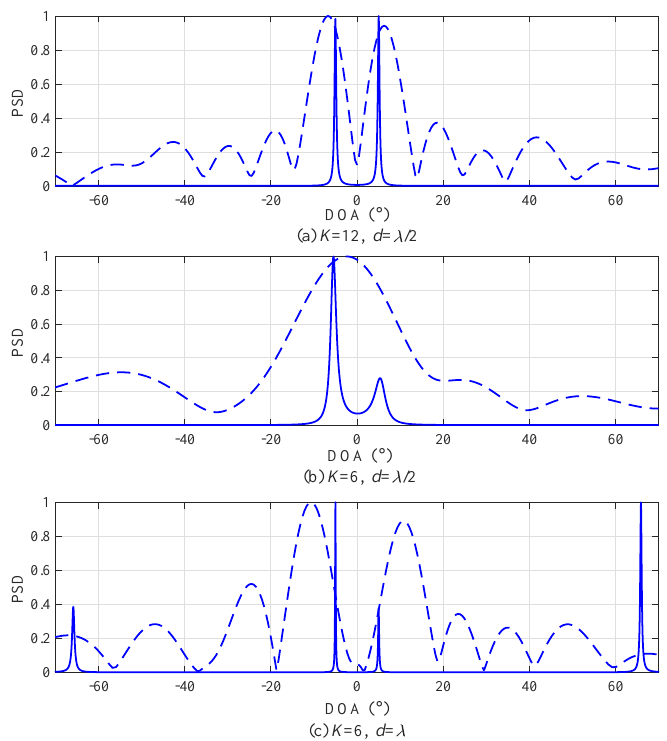
Figure 6. Power spectral density of multiple-single classifier (MUSIC) and fast Fourier transform (FFT) with d = λ /2 and d = λ